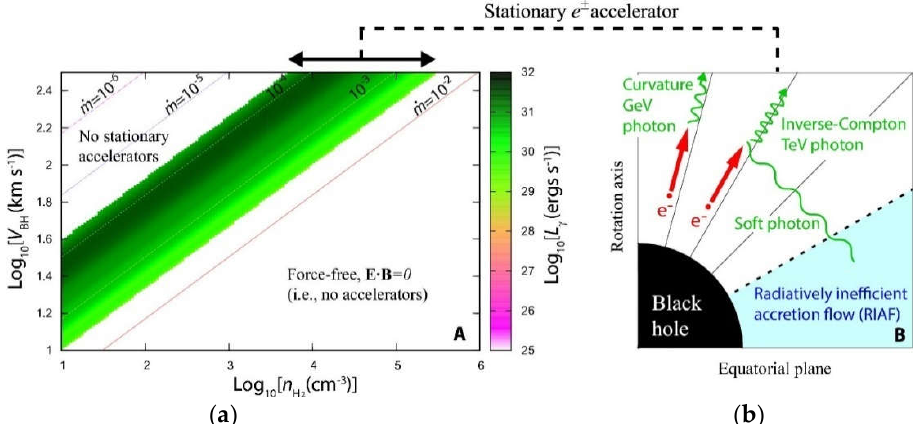
Figure 11. ( a ) Luminosity of BH lepton accelerators when a 10-solar-mass, extremely rotating ( a = 0.99 M ) BH is moving with velocity V in a cloud whose molecule hydrogen density is n H straight lines correspond to the Bondi-Hoyle accretion rates, 10 − 2 , 10 − 3 , 10 − 4 , 10 − 5 , and 10 − 6 , as labeled. In the lower-right white region, the gap vanishes due to efficient pair production. In the upper-left white region, stationary accelerators cannot be formed. Thus, stationary accelerators arise only in the green-black region. ( b ) Schematic figure (side view) of a BH magnetosphere. The polar funnel is assumed to be bounded from the ADAF, a kind of radiatively inefficient accretion flow (RIAF, cyan region) at colatitude θ = 60 ◦ (dashed line) from the rotation axis (i.e., the ordinate). From [67].